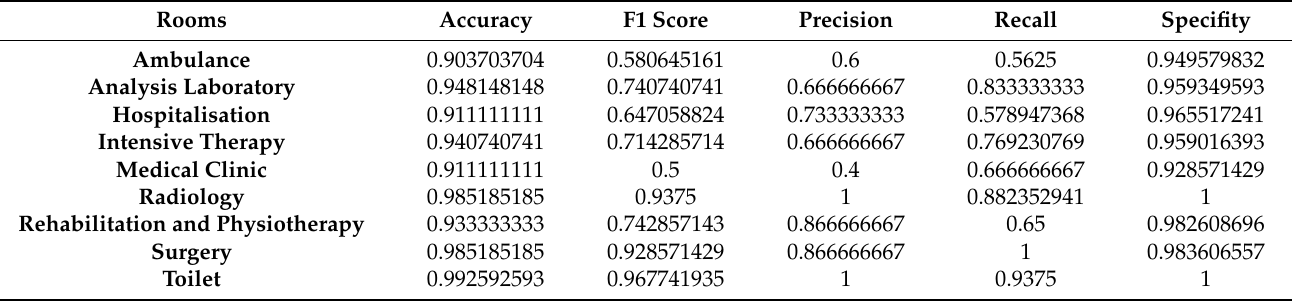
Table 19. Metrics of the RF classification algorithm obtained with the first version of the second model. Each column refers to a different metric, as defined in Section 2.4.2. Each row refers to a different